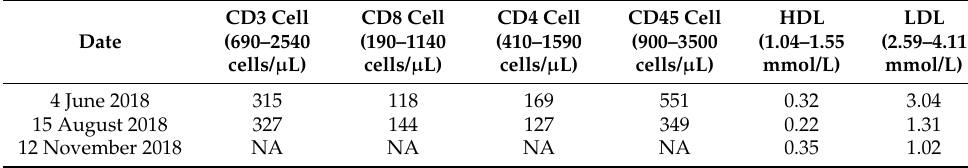
Table 2. Lymphocyte numbers and lipoproteins in the